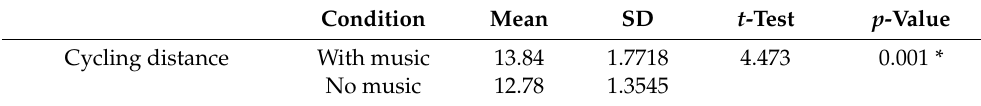
Table 6. Table with and without music for riding distance differences (Unit: km). Condition Mean SD t -Test p -Value Cycling distance With music 13.84 No music